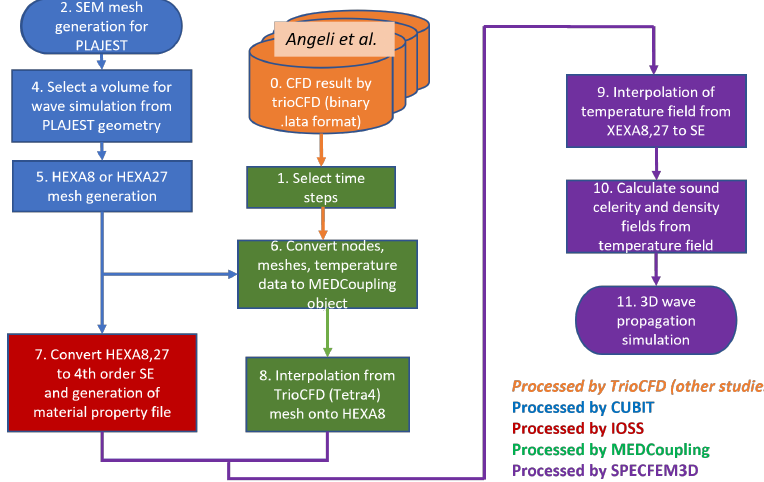
Figure 4. Data processing steps for mesh generation and preparation of the heterogeneous medium.